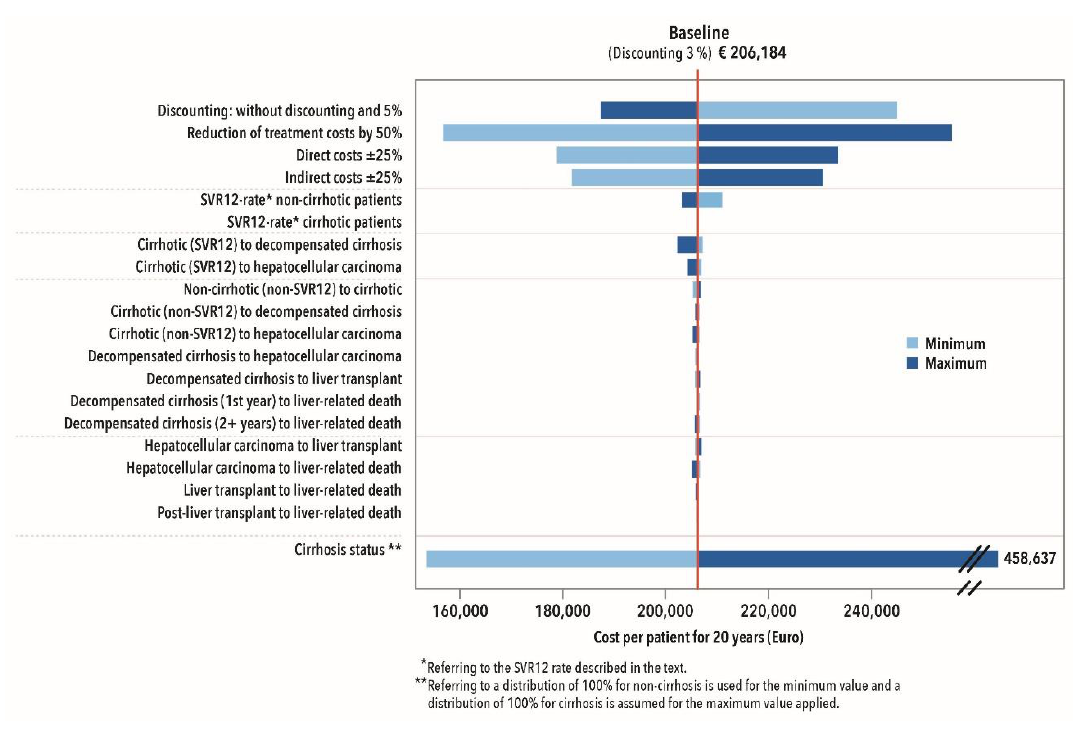
Table 4. Cost effectiveness.